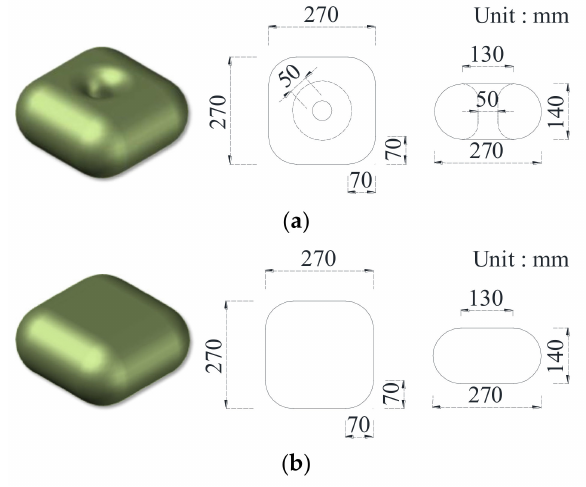
Figure 7. Details of donut and non-donut-type void shaper: ( a ) donut-type void shaper; ( b ) non- donut-type void shaper.